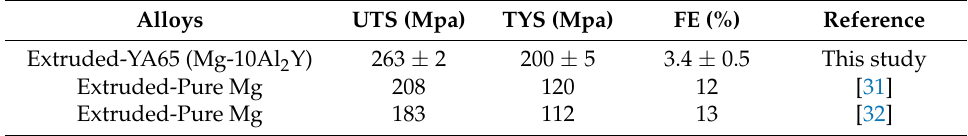
Figure 9. Tensile stress–strain curves of as-extruded YA65 alloy. Table 3. Tensile properties of the as-extruded YA65 alloy at room temperature (UTS: ultimate tensile strength; TYS: yield tensile strength; FE: elongation).